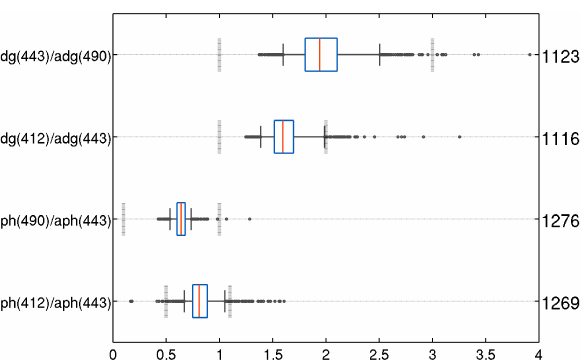
Figure 13. The distribution of absorption coefficient band ratios: adg(443) / adg(490), adg(412) / adg(443), aph(490) / aph(443) and aph(412) / aph(443). Data within 2nm of the wavelengths were used. The graphical convention is identical to Fig. 2. The vertical dashed lines show the lower and upper thresholds used for quality control in the IOCCG report 5 (IOCCG, 2006). The total number of points are divided between NOMAD (93–96%), MERMAID (3– 6%) and SeaBASS (1%).